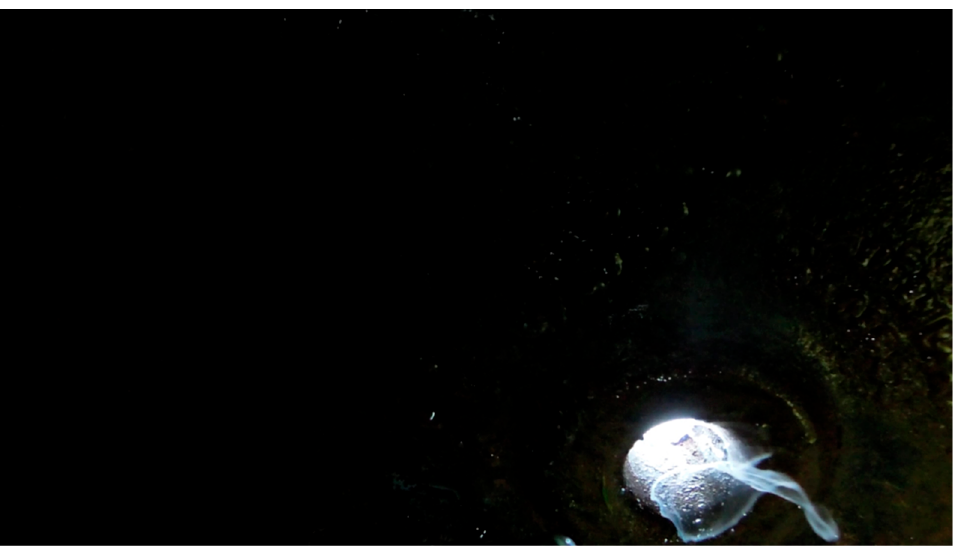
Figure 7. Downward rotational movement during entry of ‘smoke’ through the opening in the manhole cover into the airspace. This image shows the rotational motion that occurs and the tendency to move near the circumferential surface.